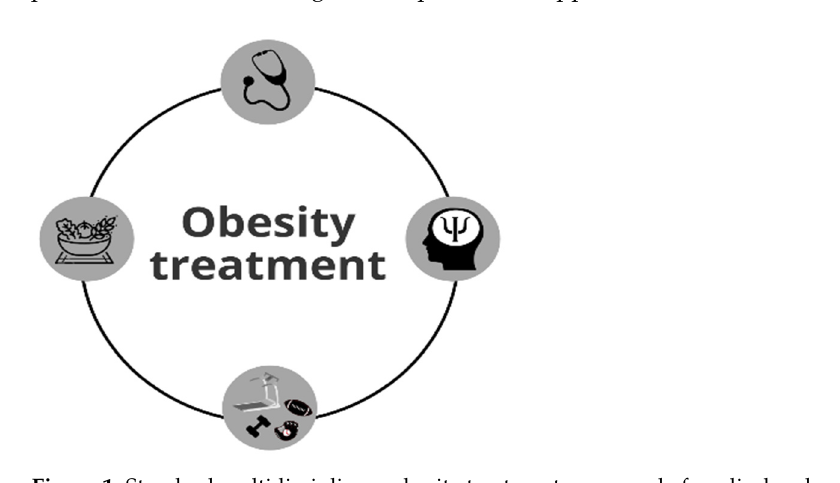
Figure 1. Standard multidisciplinary obesity treatment composed of medical and nutritional therapies along with psychological counseling and physical activity programs.